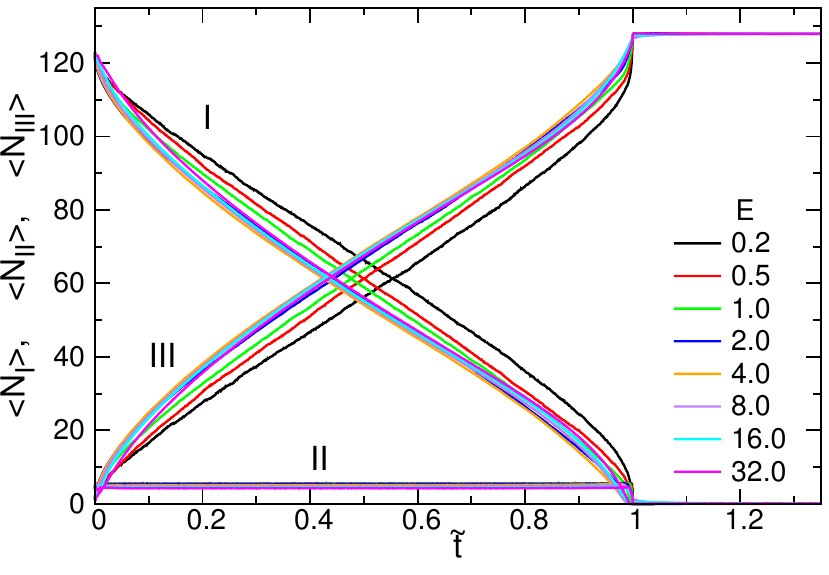
Figure 7. ˜ t -variation of the averaged N m for N = 128 in the cis-region (I); the pore-region (II); and the trans-region (III). The field strength E is indicated in the